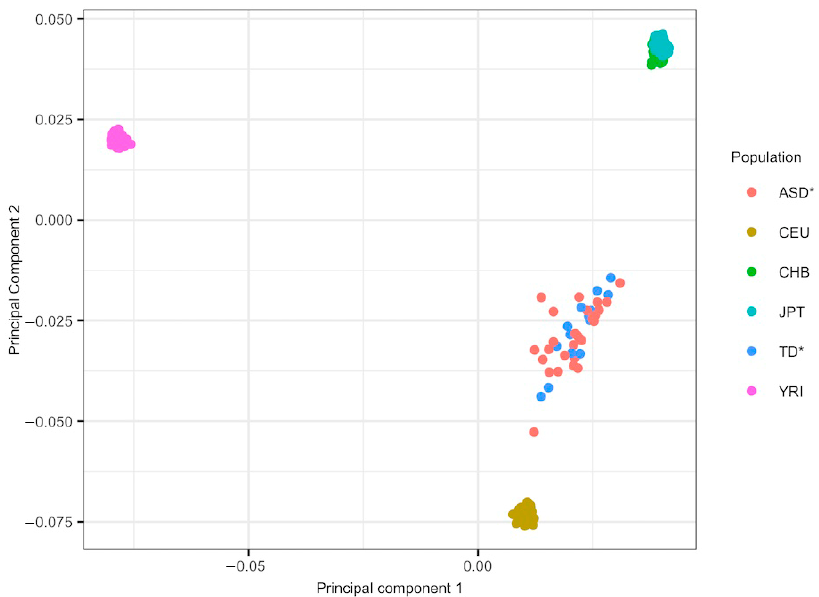
Figure 1. Principal components analysis (PCA) of participants’ genotypes along with HapMap3 populations data. CEU: Utah Residents with Northern and West European ancestry; CHB: Han Chinese in Beijing, China; YRI: Yoruba in Ibadan, Nigeria; JPT: Japanese in Tokyo, Japan; ASD*: Autism Spectrum Disorder diagnosed subjects from this study; TD*: Typically developing subjects from this study.